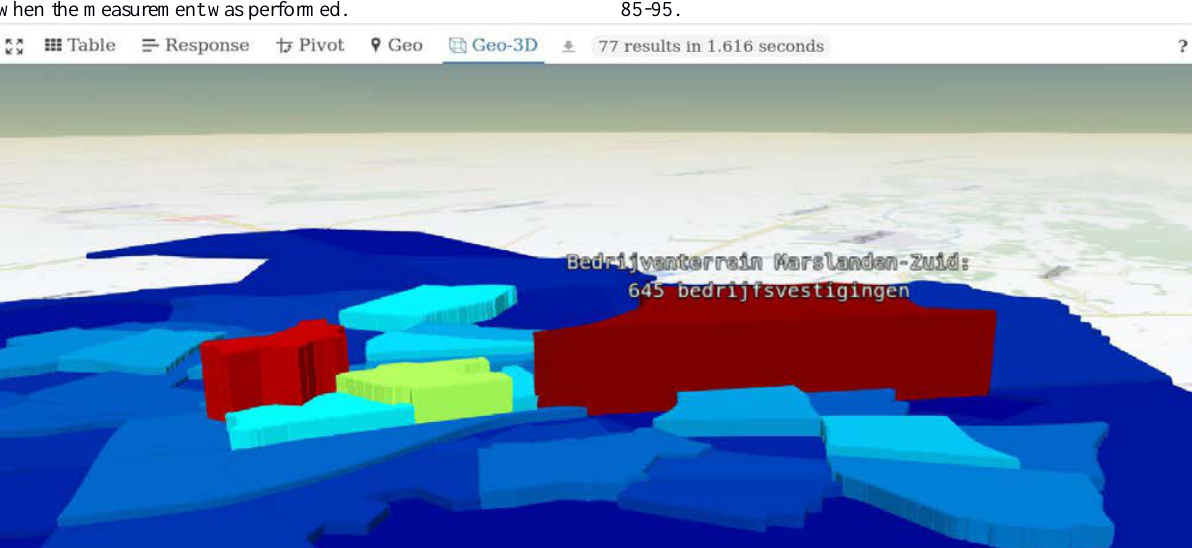
Figure 3. Result with number of businesses as 3D